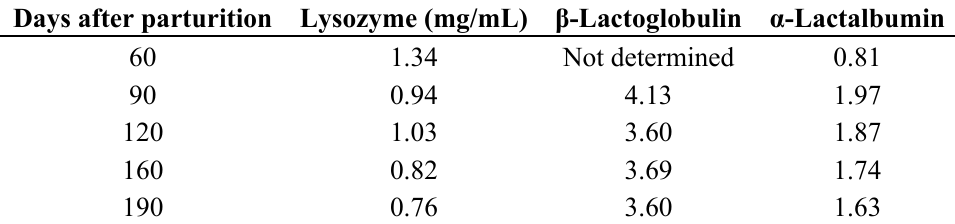
Table 3. Quantitative determination of lysozyme, β-lactoglobulin, α-lactalbumin in different stages of lactation  25 